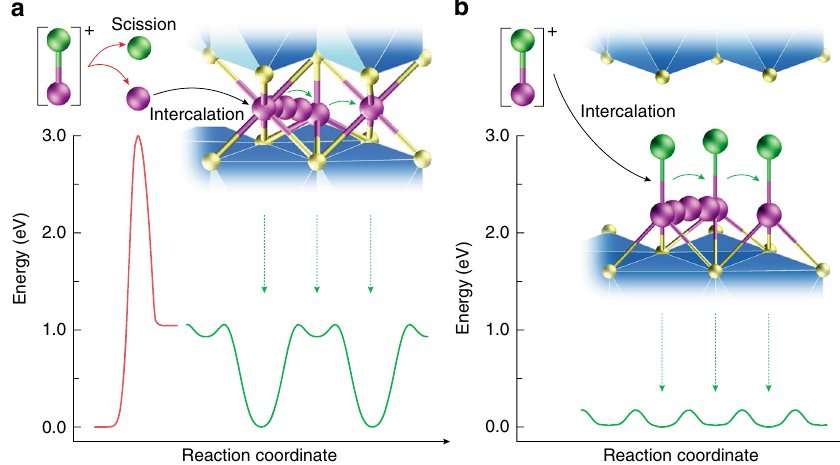
Fig. 1 Energy diagrams for the intercalation and diffusion of Mg 2+ and MgCl + . a Typical intercalation of Mg 2+ involves scission of MgCl + ions into Mg 2+ and Cl − , which requires substantial activation energy of 3 eV at least. Subsequent diffusion of divalent Mg 2+ also has a high-migration energy barrier of 1.06 eV, which results in the limited level of intercalation at room temperature. b Intercalation of MgCl + bypasses the sluggish scission of the Mg – Cl bond at the electrolyte – cathode interface; afterwards MgCl + diffuses fast in the expanded interlayers due to the fairly low-migration energy barrier of 0.18 eV. Mg and Cl atoms are shown as purple and green spheres ,